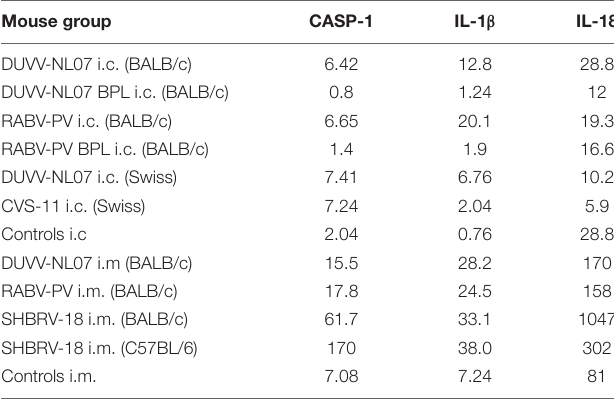
TABLE 4 | Mean transcript numbers relative to β -actin per nanogram of RNA of key pyroptotic genes measured by real-time qRT-PCR in the brains of the different mouse